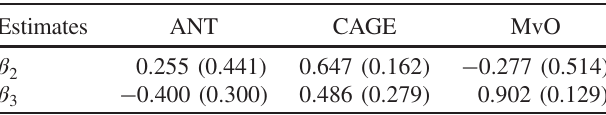
TABLE IV. Estimated coefficients and associated p values (in parentheses) for the logistic regression model for consis- tently demonstrating a level confusion as predicted by confidence on ANT:HUGE, CAGE, and MvO:ONE. No p values were significant.